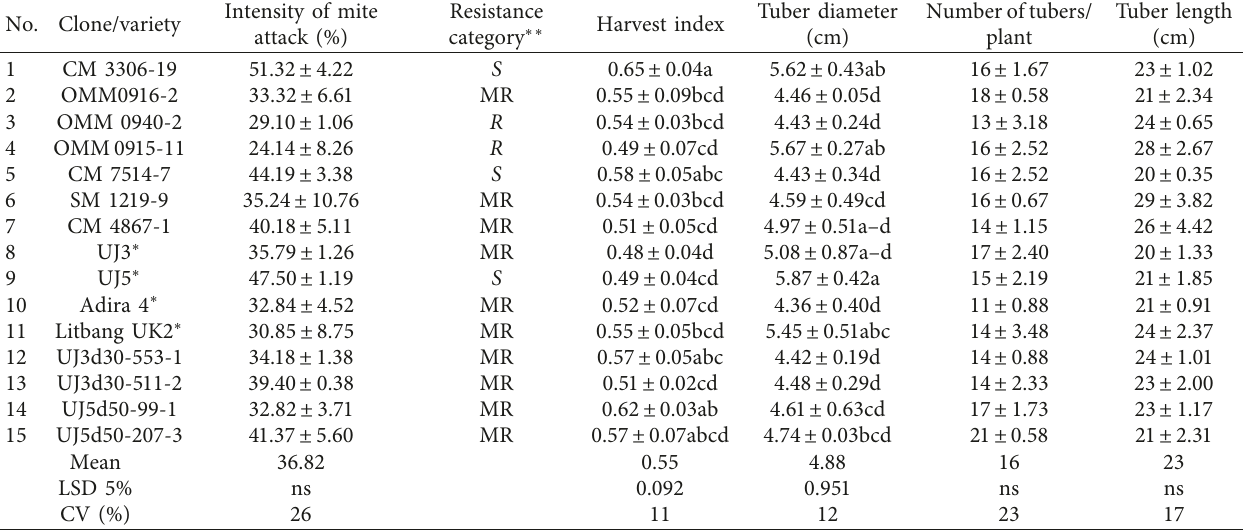
Note . ∗ Varieties. Table 2: Intensity of mite attack ( ± SE), harvest index ( ± SE), tuber diameter (cm ± SE), number of tubers/plant ( ± SE), and tuber length (cm ± SE) of cassava promising clones in Malang,